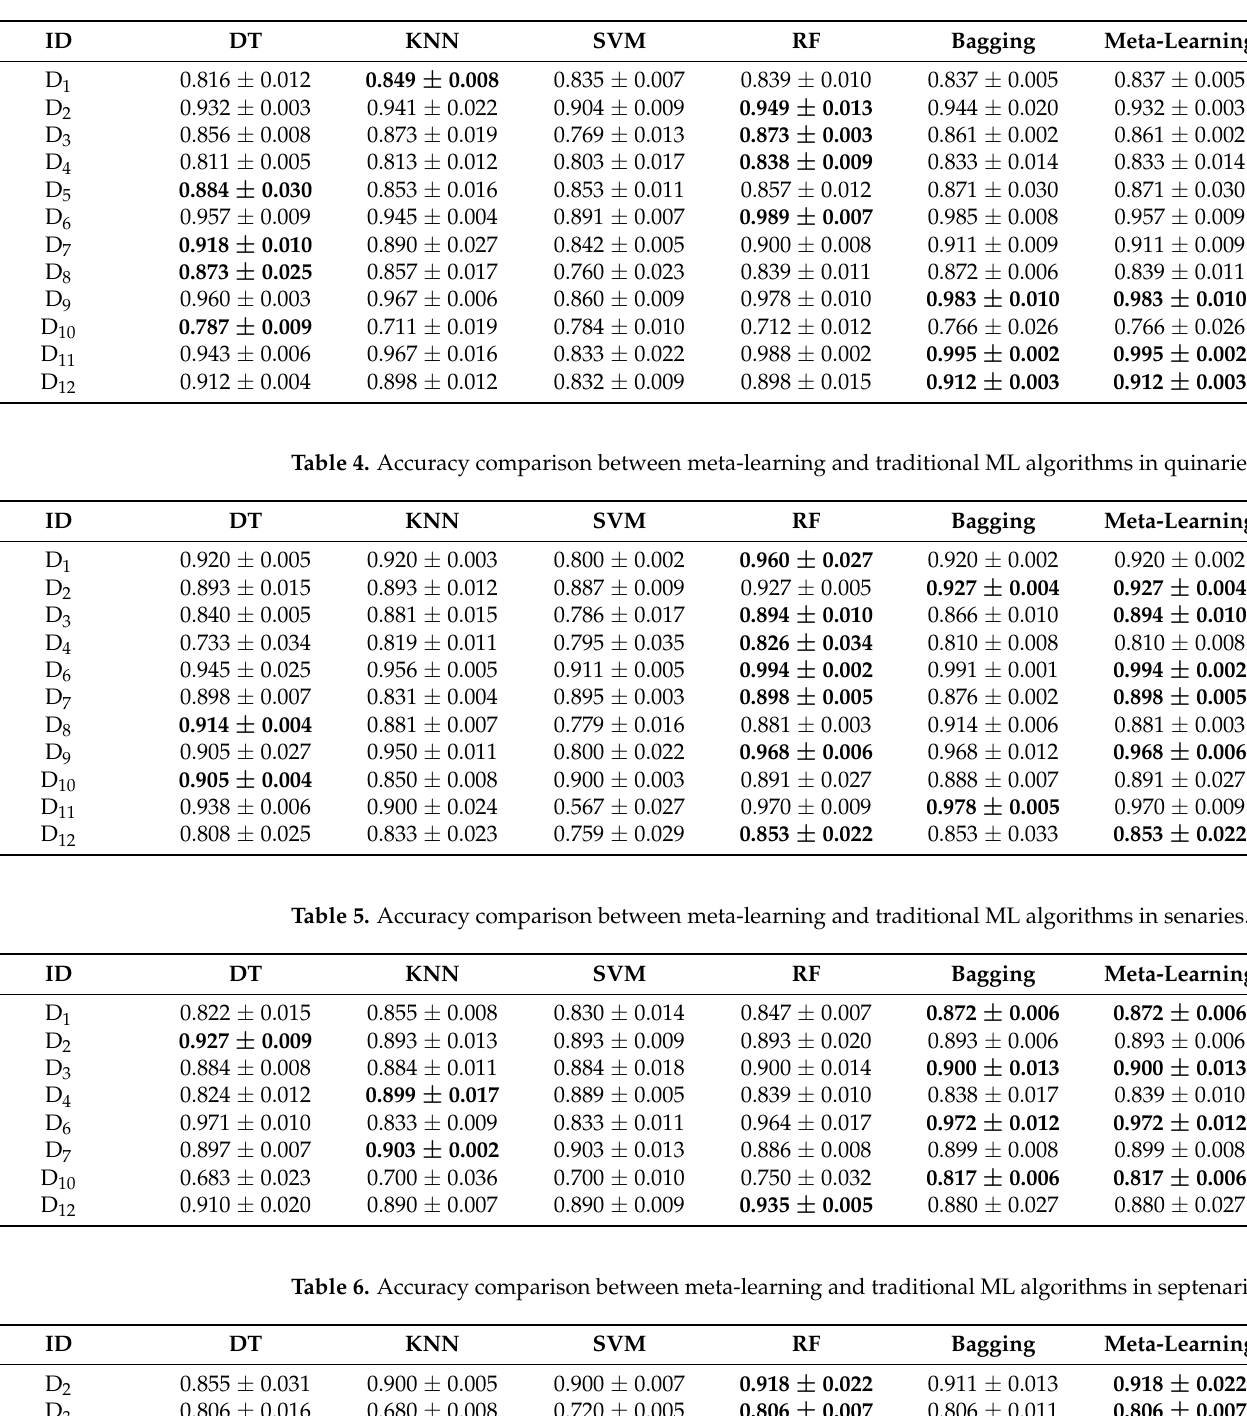
Table 3. Accuracy comparison between meta-learning and traditional ML algorithms in all.